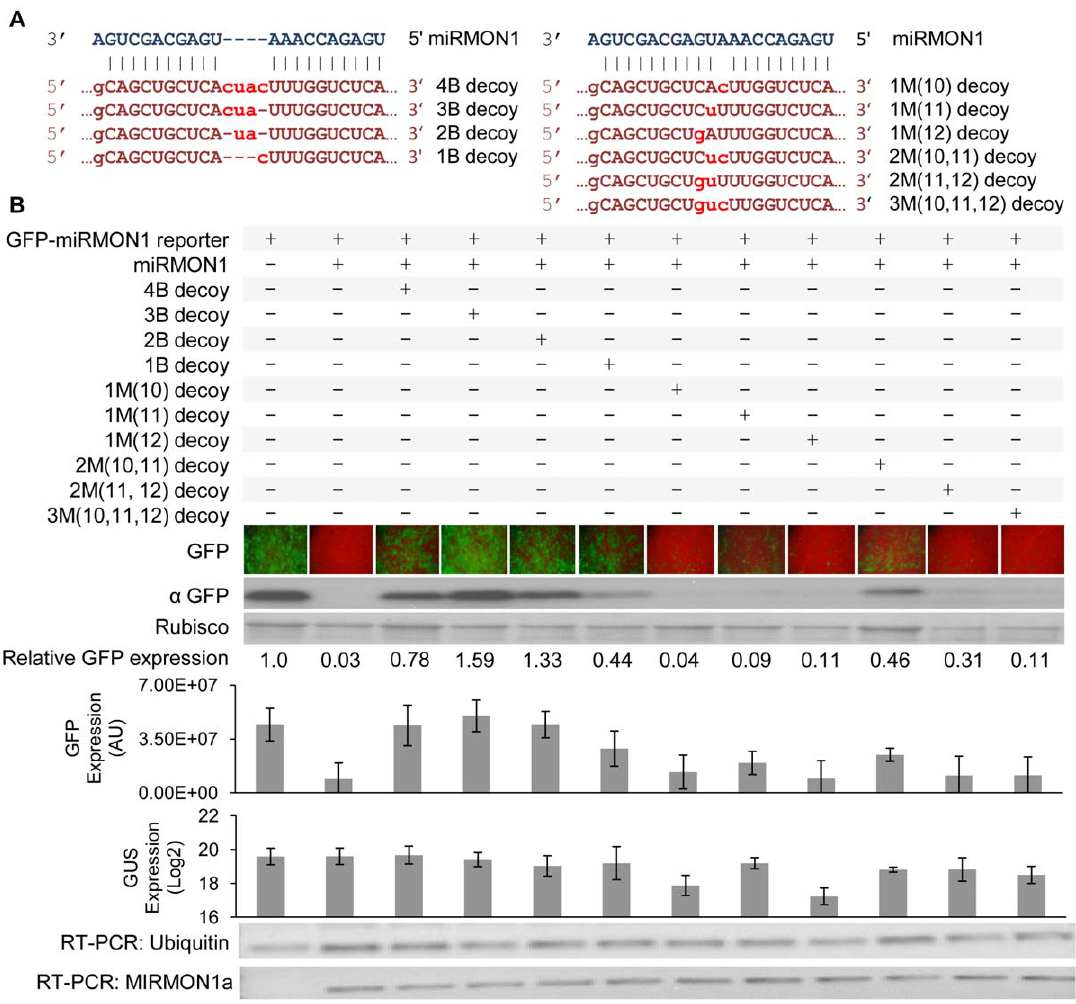
Figure 4. Effect of miRNA decoy structure on efficacy. ( A ) Sequence of miRMON1 decoys with bulged (4B, 3B, 2B, 1B) or mismatched (1M, 2M, 3M) structures at various positions between 10 and 12 of the miRNA (position of mutation in parentheses). ( B ) Expression of miRMON1-targeted GFP reporter co-expressed with various miRNA decoys in N. benthamiana leaves measured by fluorescence microscopy and Western blot. Leaves were co- transformed with one part GFP reporter, 5 parts miRMON1, and 10 parts miRNA decoy. Agrobacterium transformed with an empty vector was added to achieve a total OD 600 =1 of Agrobacterium for each transformation. The Rubisco band visualized by Ponceau staining shows the loading control. Relative GFP expression normalized to Rubisco is indicated. Relative GUS expression as measured by qRT-PCR indicates decoy expression, and miRMON1 expression was determined by semi-quantitative RT-PCR.